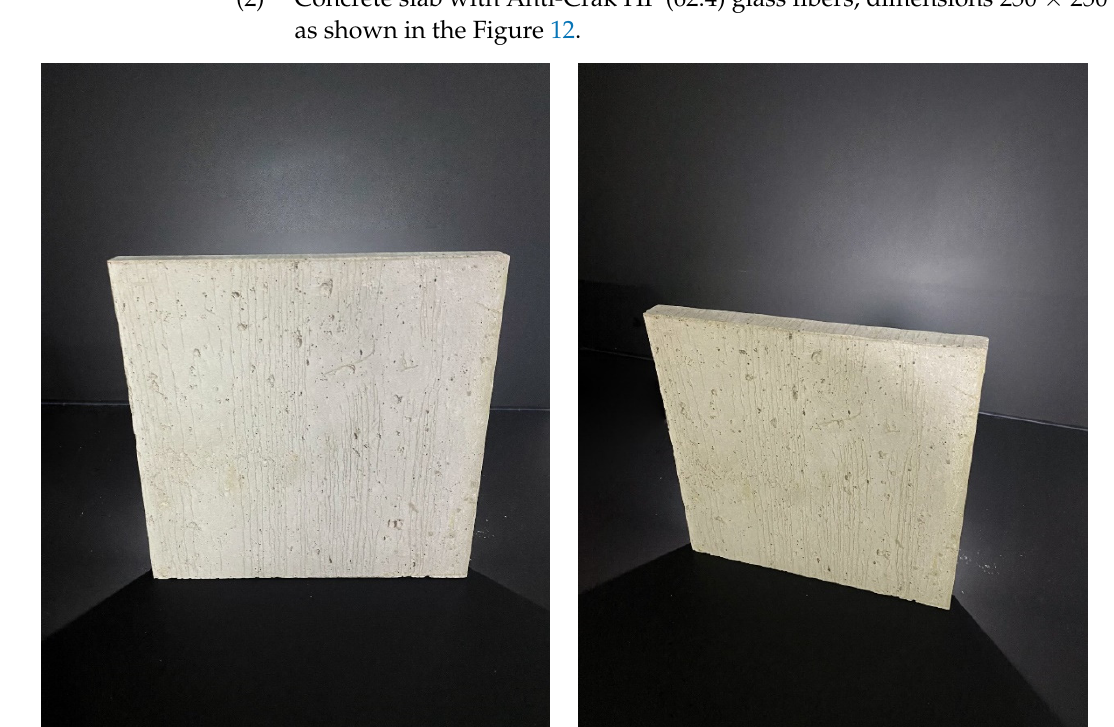
Figure 12. Concrete solid slab.